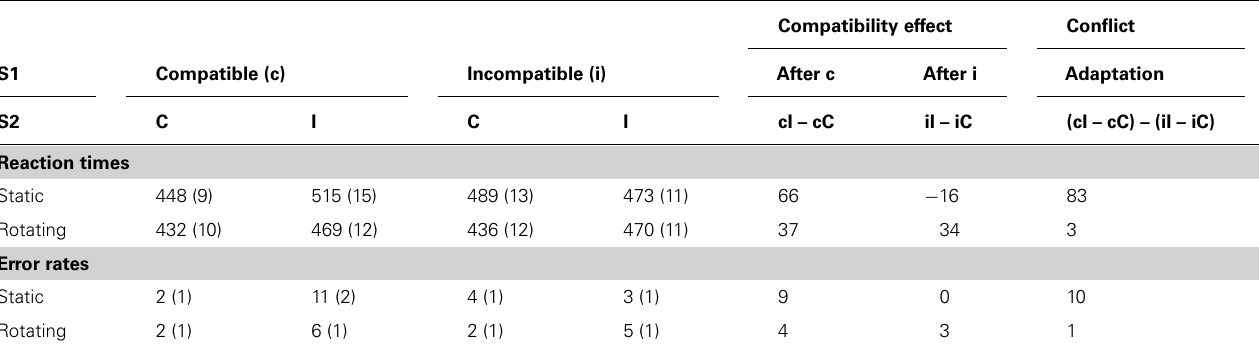
Table 1A | Experiment 1, compatibility and conflict-adaptation